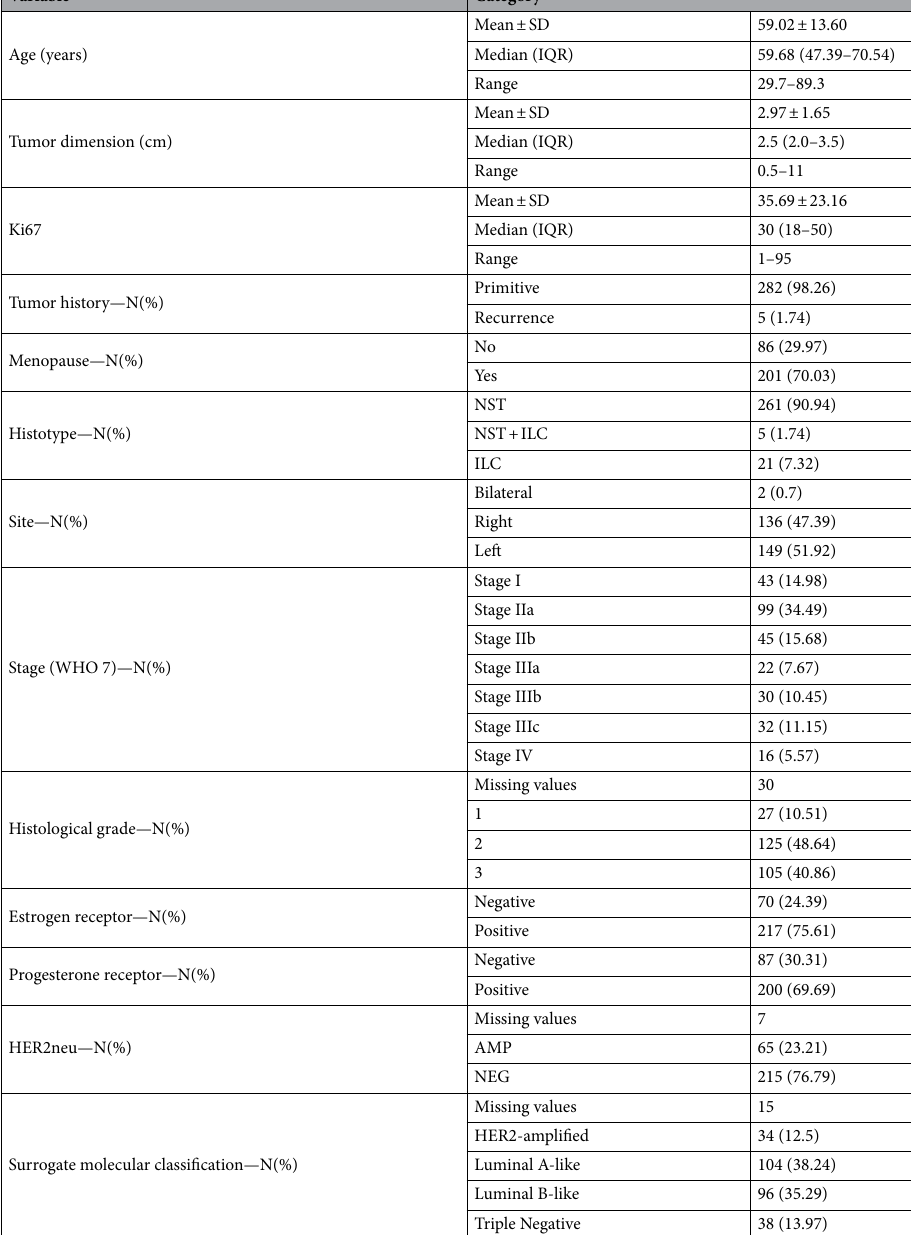
Table 1. Clinicopathological characteristics of the H-CSS patient cohort (N =